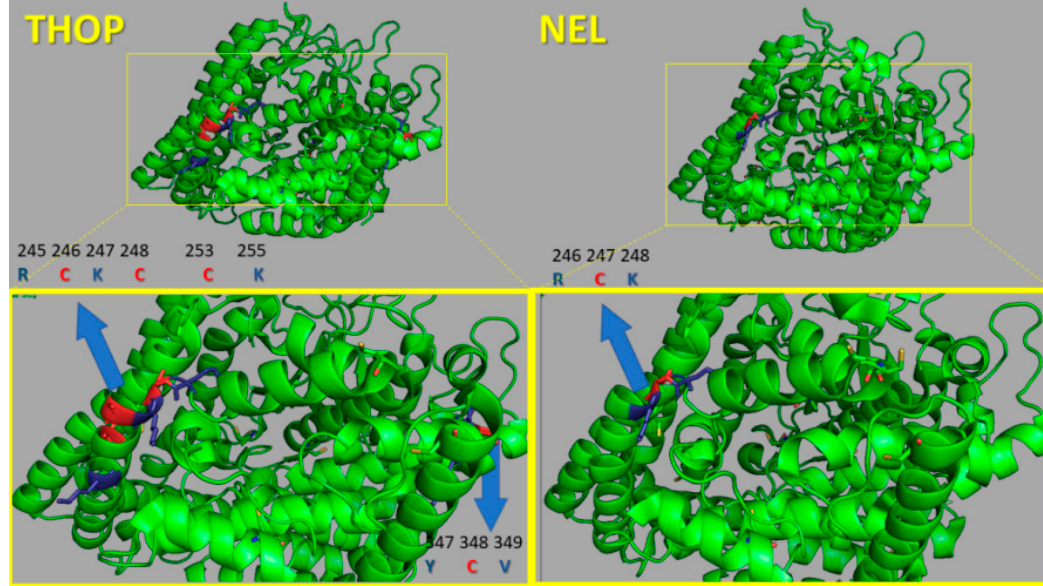
Figure 9. Comparative cartoon of Protein Databank (PDB) structure of THOP and NEL highlighting cysteine and basic amino acid residues of each enzyme. In THOP structure, there are three exposed acidic cysteine residues: C246, C248 and C253, whereas NEL has only one exposed acidic cysteine residue that is C247. In the cartoon structures, cysteines are highlighted in red while the neighbor basic amino acids R and K are highlighted in blue.